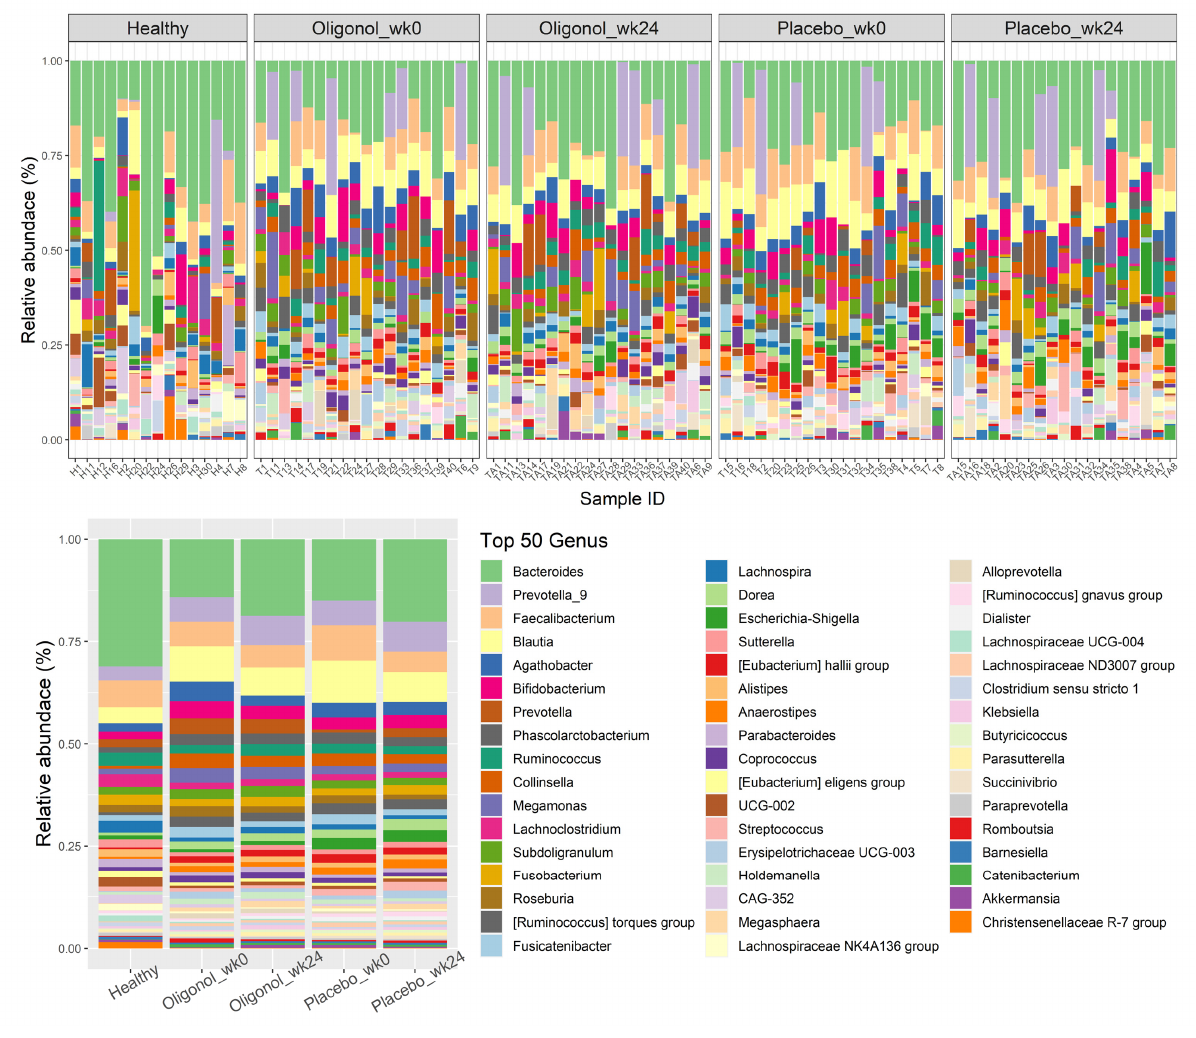
Figure 5. Top 50 relative abundance of bacterial genera at week 0 and week 24 in the oligonol and placebo